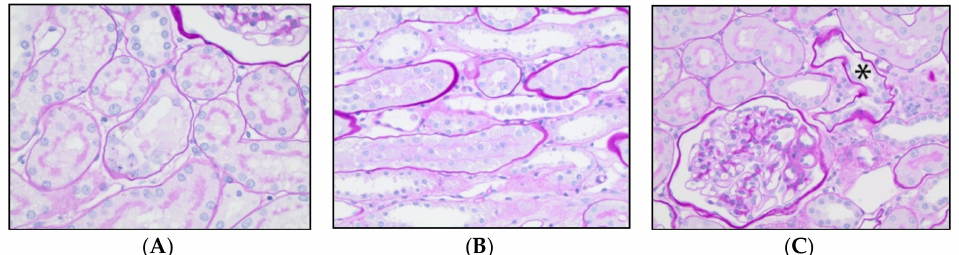
Figure 3. ( A ) Photomicrograph from a control dog with mild acute tubular epithelial injury, charac- terized by loss of the brush border and simplification of the tubular epithelium. There are 2 sloughed necrotic cells within the lumen. ( B ) Photomicrograph from a treated dog with mild acute tubular epithelial injury characterized by the presence of many sloughed epithelial cells within a tubular lumen. ( C ) Photomicrograph from a treated dog that had moderate acute tubular epithelial in- jury, characterized by simplification and attenuation of tubular epithelium (asterisk) that was more frequently observed than in dogs with mild injury. Periodic acid Schiff, 40 × magnification.